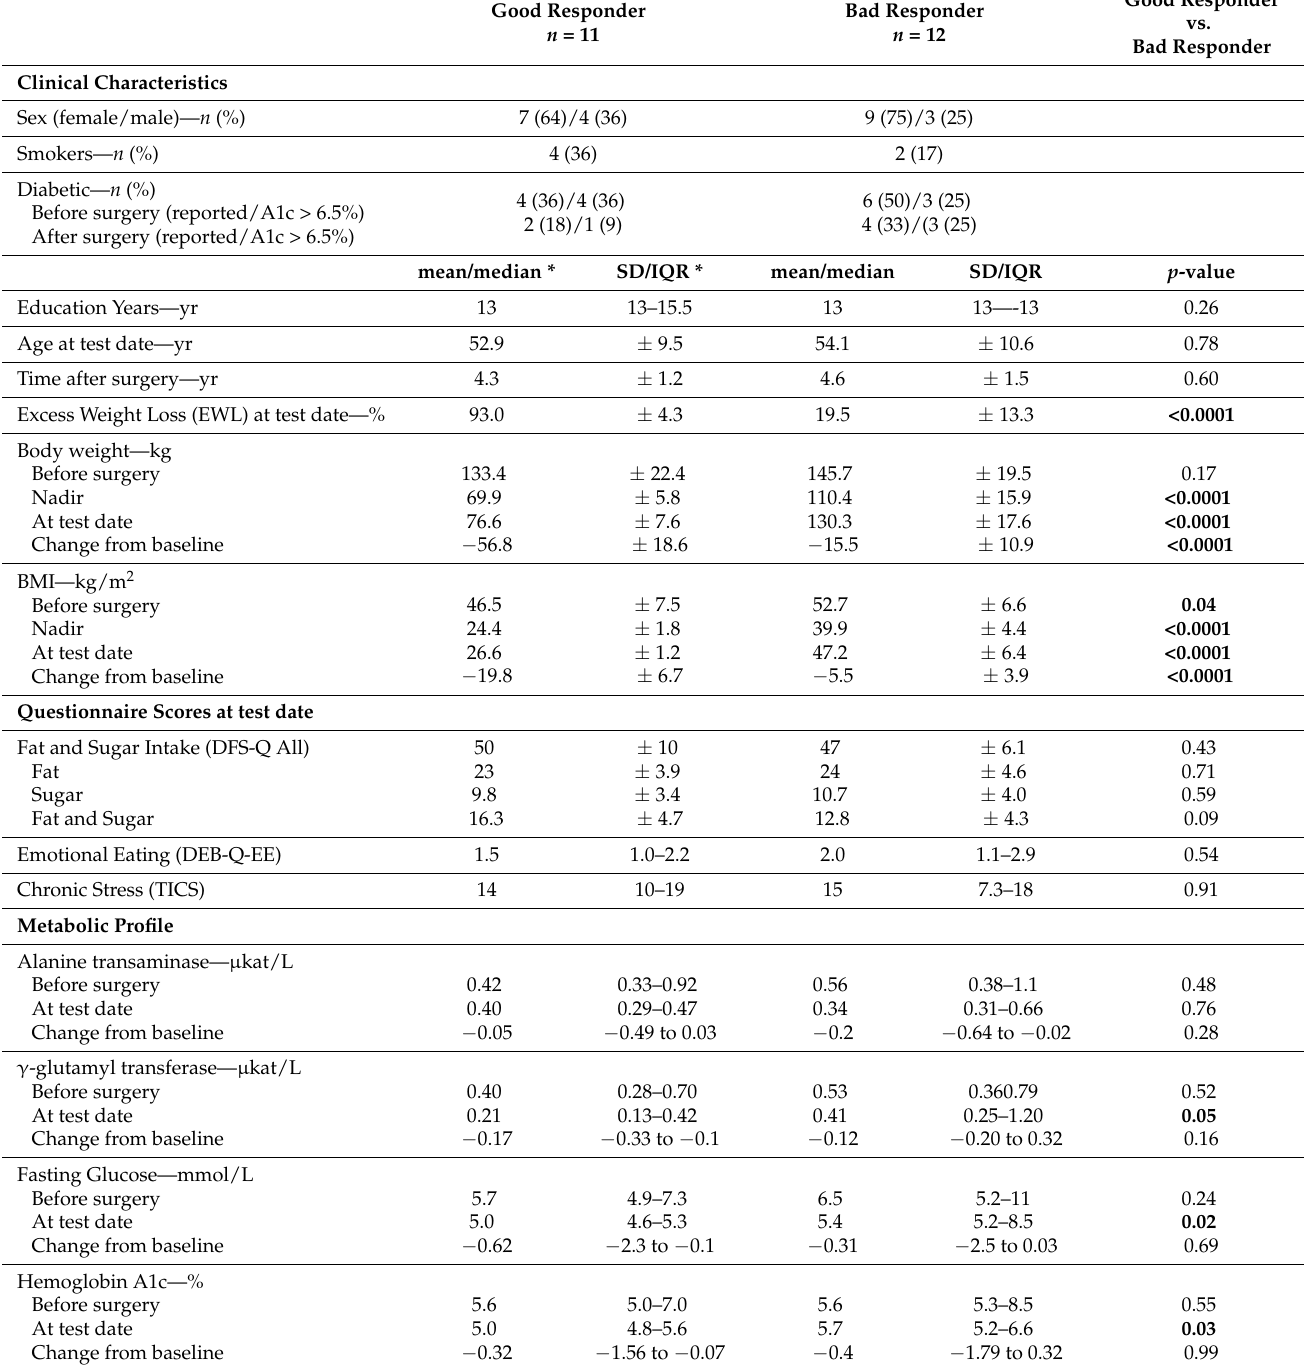
Table 1. Anthropometric data, eating behavior and metabolic profile of the study cohort ( n =